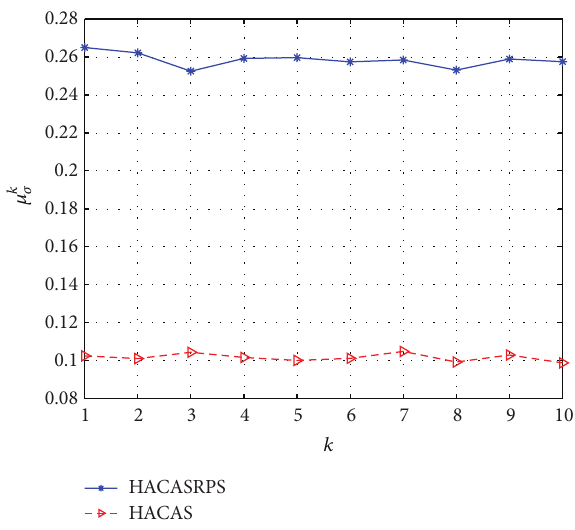
Figure 10: The load variations of HACAS and HACASRPS algo- rithms in different simulation cycles; 𝑘 is the simulation cycle, and 𝜇 𝑘 𝜎 is the load variation of the algorithm in the